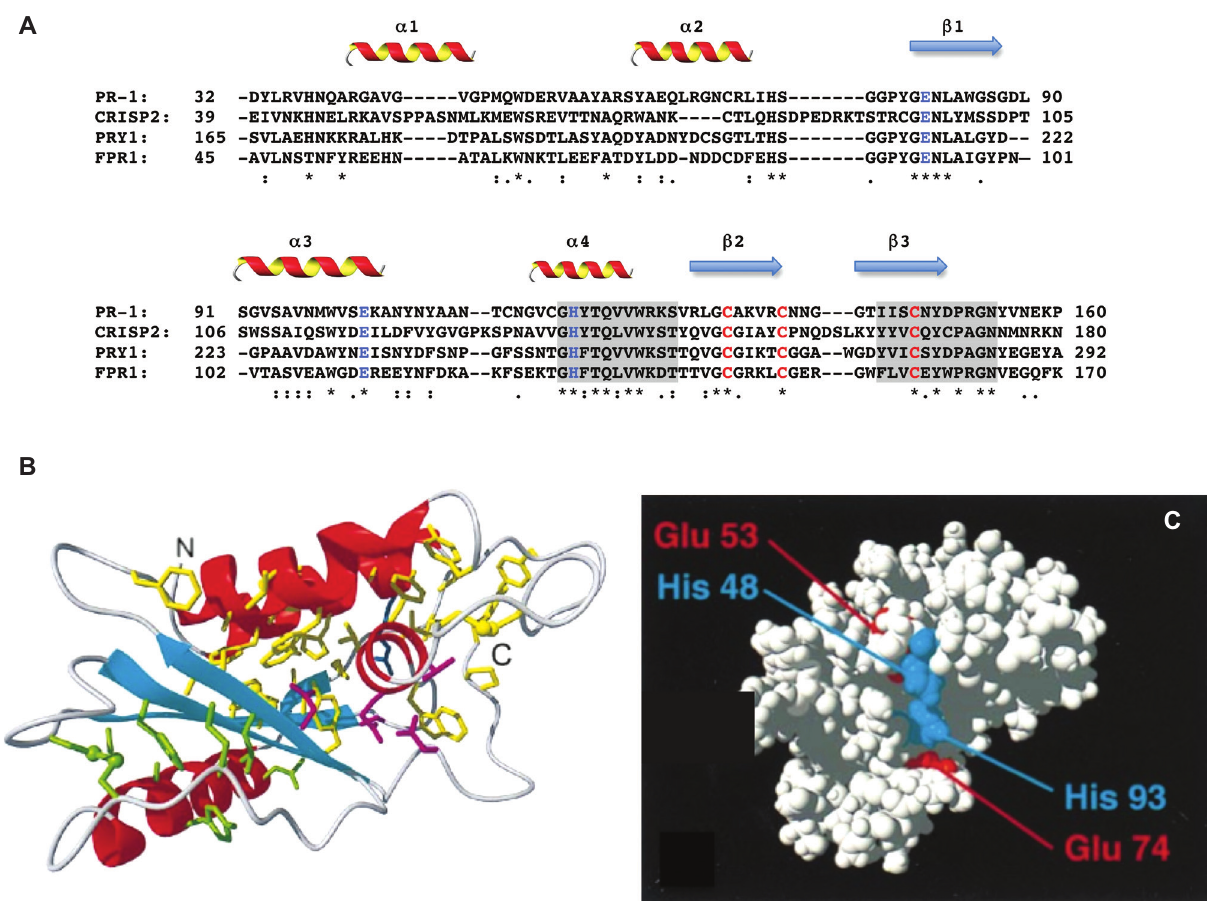
Figure 1 Conservation and structure of the CAP